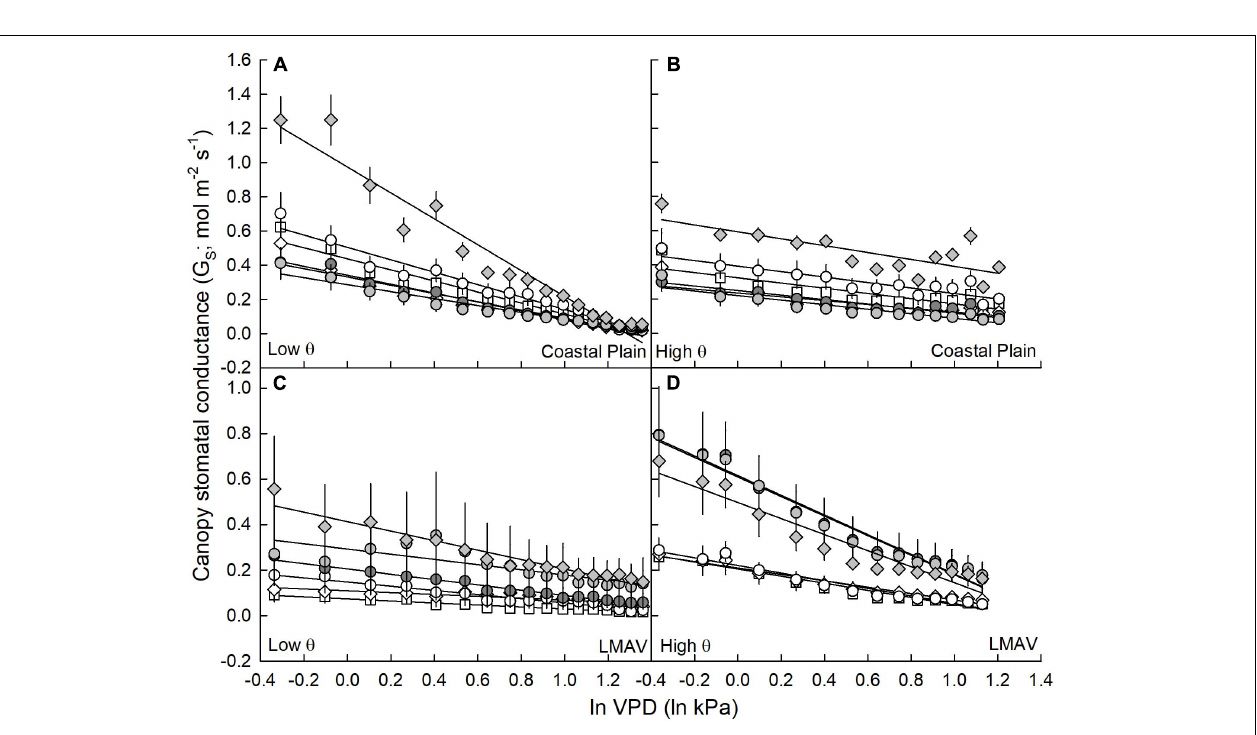
FIGURE 3 | Canopy stomatal conductance (G S ; mol m − 2 s − 1 ; mean and SE) vs. the natural log of vapor pressure deficit (ln VPD; ln kPa) under (A,C) low soil moisture ( θ ; cm 3 cm − 3 ) conditions and (B,D) average to high soil moisture conditions. Eastern cottonwoods (D × D) including varietals 110412 (white circles), S7C8 (white diamonds) and ST66 (white squares) and hybrid poplars in the P. deltoides × P. maximowiczii taxa (D × M) including 6329 (light gray circles) and 8019 (light gray diamonds) and the P. trichocarpa × P. deltoides taxa (T × D) including varietal 5077 (dark gray circles) for trees at the (A,B) Coastal Plain and (C,D) LMAV sites are